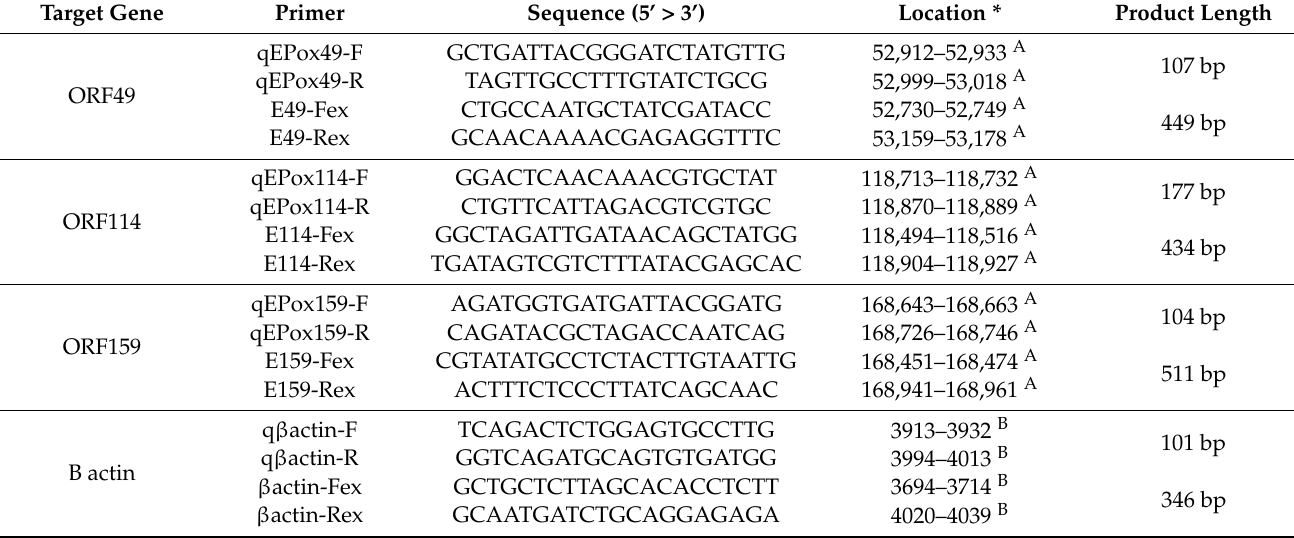
Table 1. Detailed list of primers used in the present